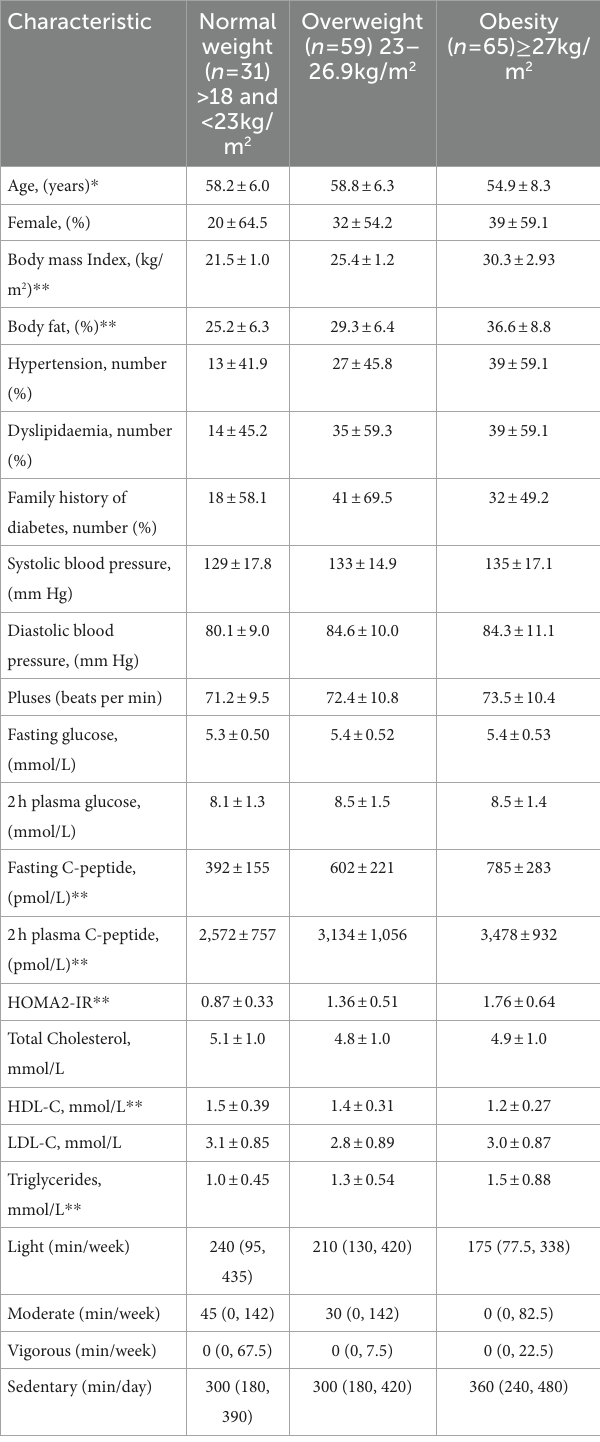
TABLE 1 Characteristics of the study cohort. TABLE 2 Median consumption of macronutrients and minerals by BMI